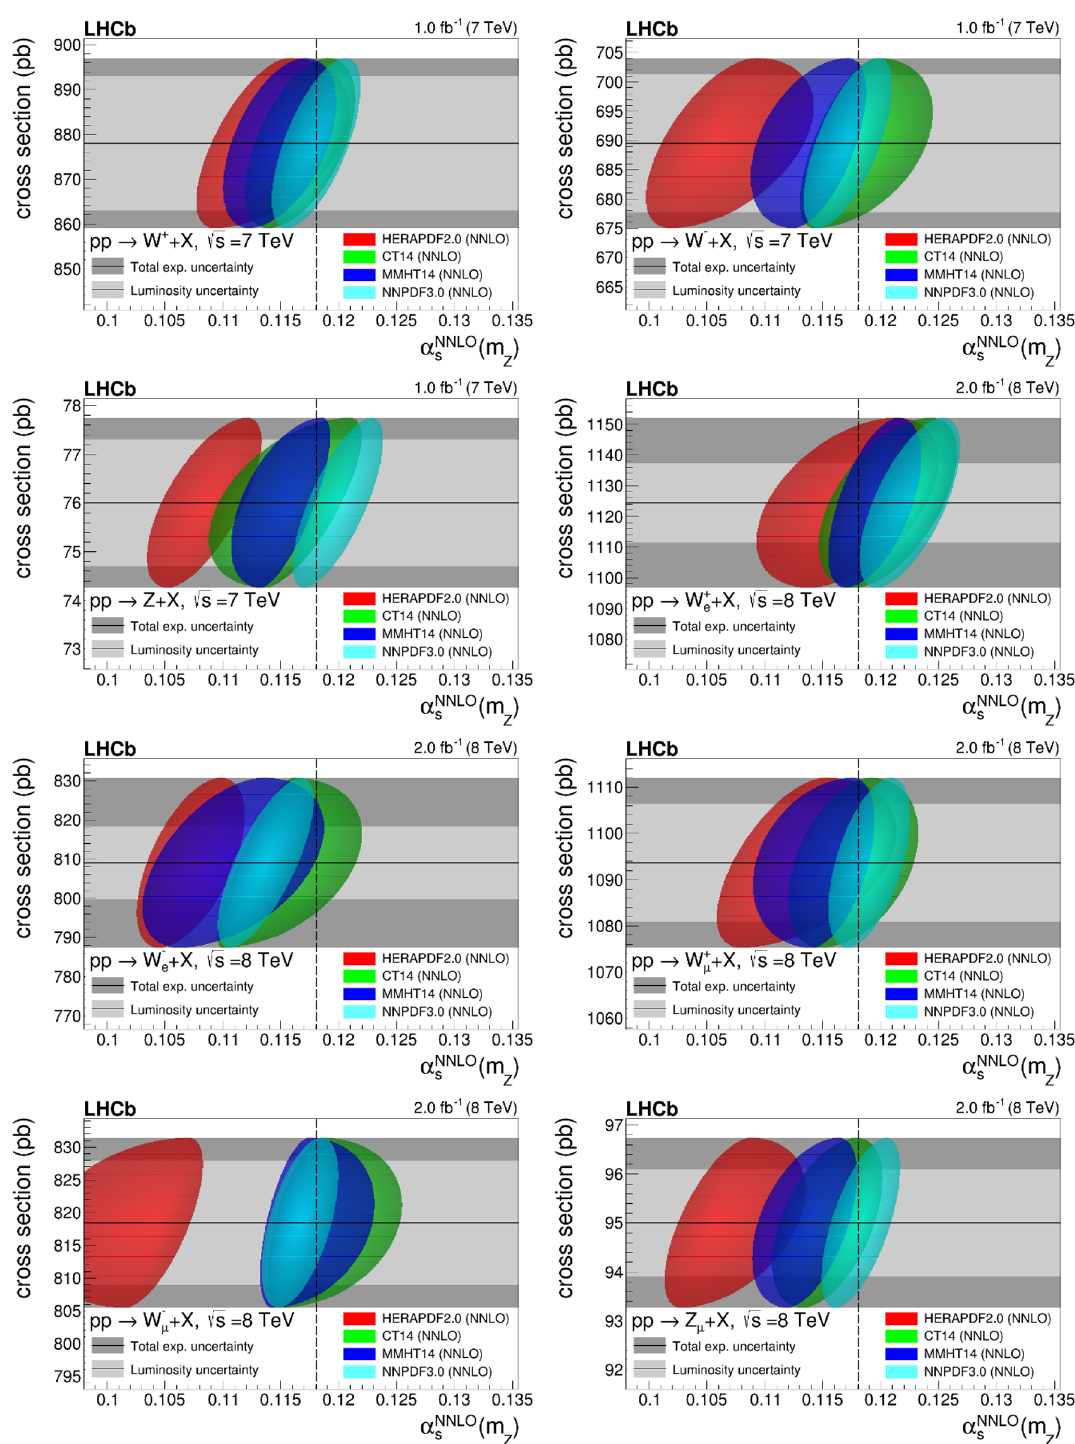
Figure 2 . Same as (cid:12)gure 1 for the LHCb measurements of the cross sections for W + (upper left), W (cid:0) (upper right), Z (second row, left) bosons in pp collisions at row, right), W (cid:0) (third row, left), W + (third row, right), W (cid:0) e (cid:22) p bosons at s = 8 TeV.